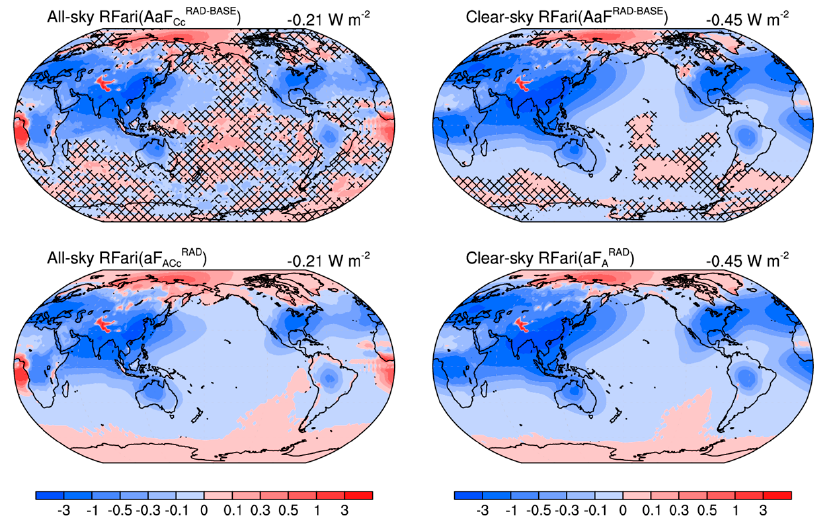
Figure 1. Annual mean maps for the present-day (year 2000) anthropogenic aerosol all-sky ( left ) and clear-sky ( right ) instantaneous radiative forcing from aerosol–radiation interactions (RFari). The results calculated as the differences between the RAD and BASE experiments are shown in the upper panels. The results provided by the RAD experiment only are shown in the lower panels. The global average is given in the upper-right corner. Hatching represents the nonsignificant area at the 90% confidence level of Student’s t -test.